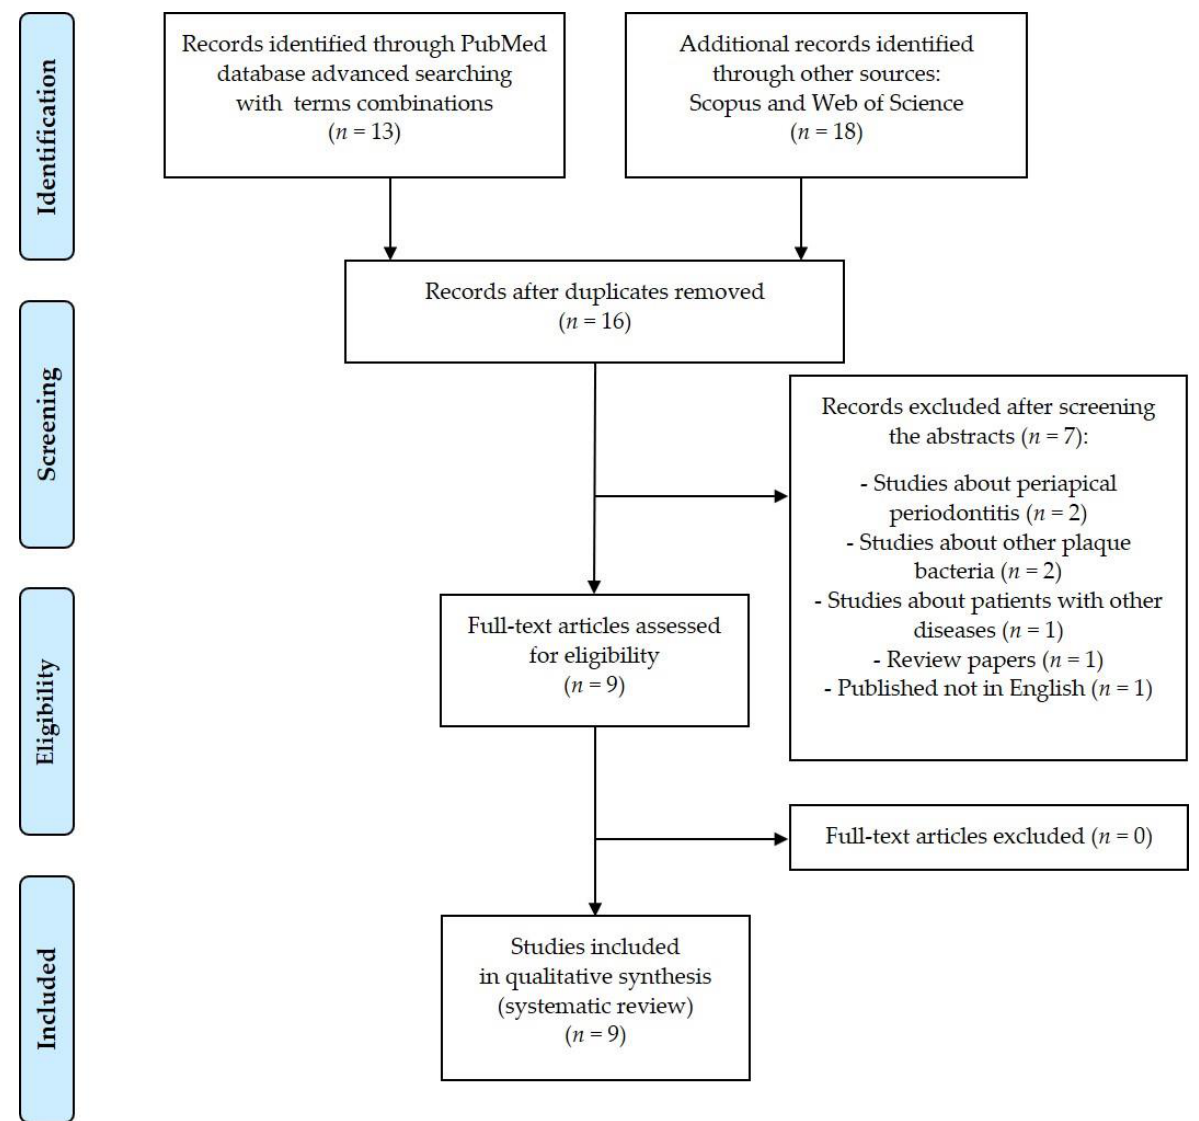
Figure 1. PRISMA flow diagram presenting the detailed search strategy.